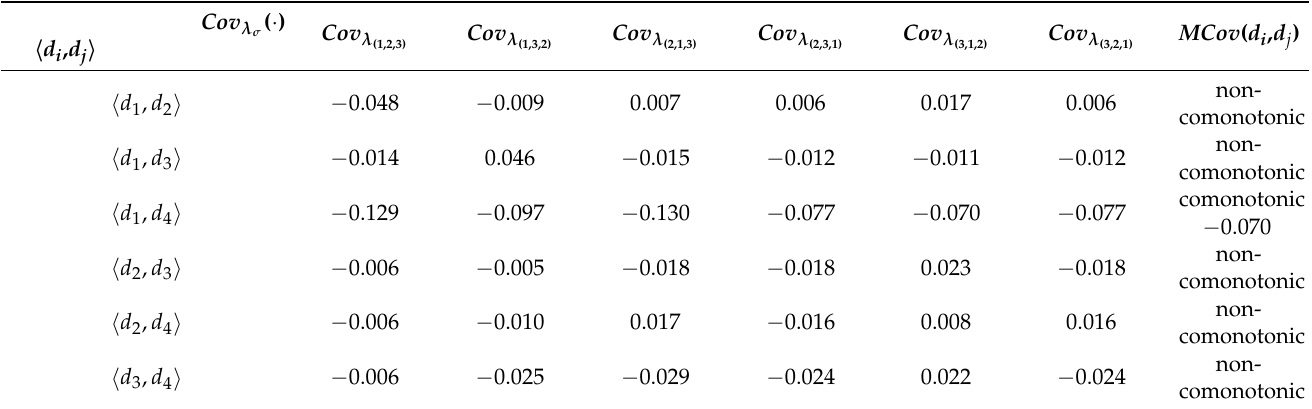
Table 5. Associated covariances and monotone covariances for the pairs of alternatives. (cid:68)